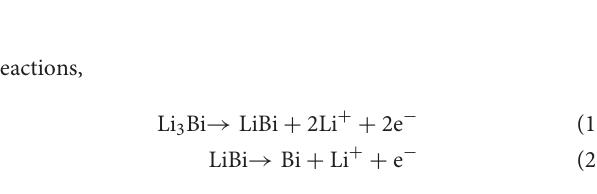
FIGURE 6 | Lattice parameters of the (A) Li 3 Bi and (B,C) LiBi phases as a function of